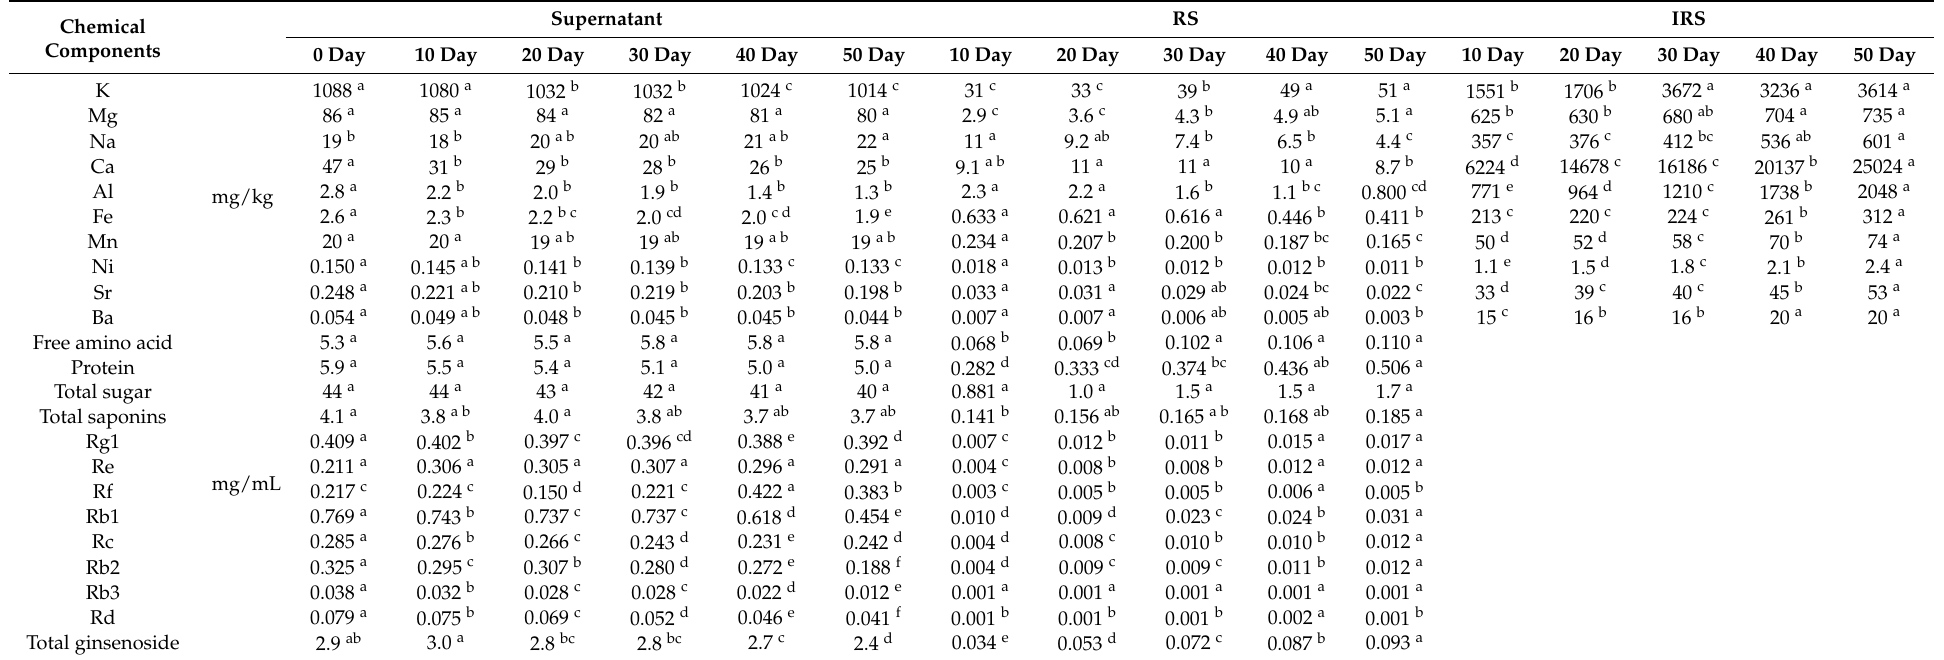
Table 2. Chemical composition analysis of ginseng supernatant, RS and